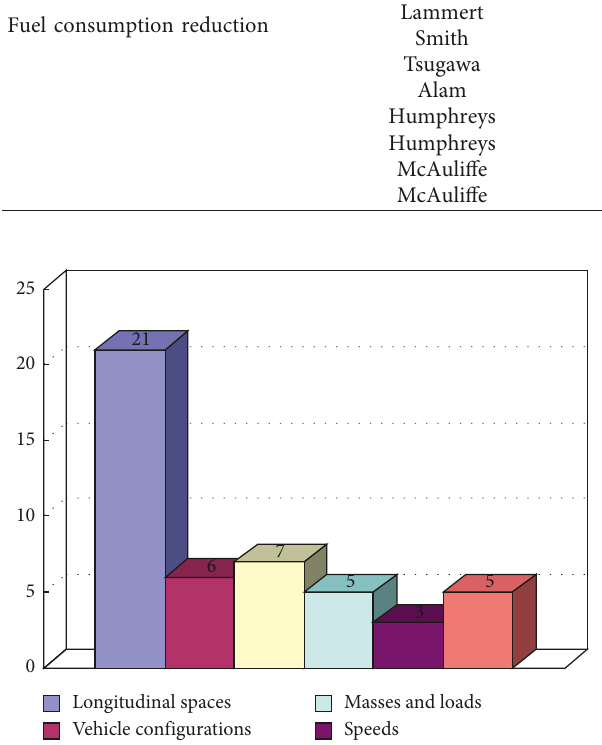
Figure 1: The reference number of different influencing factors.